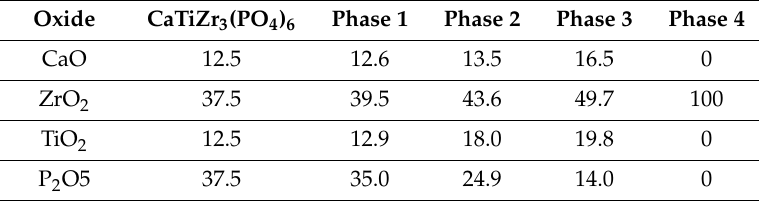
Figure 3. Cross-sectional images of plasma-sprayed CaTi 4-x Zr x (PO 4 ) 6 coatings. ( A ): CZ 4 P 3 coating (plasma power 36 kW, spray distance 90 mm, argon gas flow rate 50 slpm, hydrogen gas flow rate 10 slpm). ( B ): Enlarged image of ( A ) [30]. © Images courtesy of Dr. Guido Reisel, Oerlikon Metco. ( C ): CTZ 3 P 3 coating (plasma power 35 kW, spray distance 120 mm, argon gas flow rate 50 slpm, hydrogen gas flow rate 12 slpm) [16,31]. ( D ): X-ray diffraction pattern of phase-pure CTZ 3 P 3 starting powder (a), calculated interplanar spacings (b) and a plasma-sprayed coating (c). The dots indicate the presence of ZrP 2 O 7 , one of the decomposition products of incongruent melting. Table 3. Composition in mole% of the phases identified in Figure 3C.